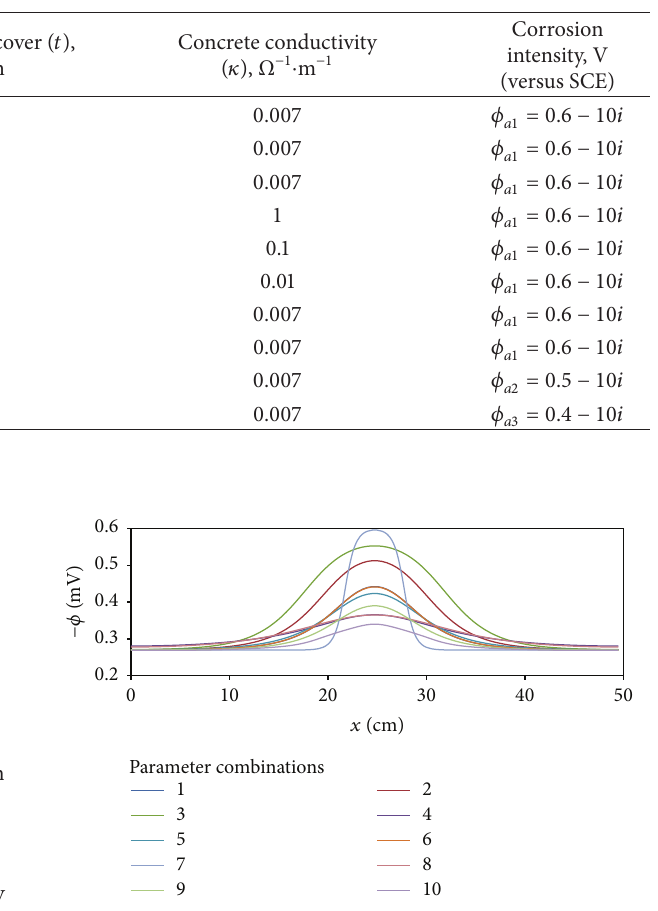
Table 1: 10 combinations of parameters for evaluating the nature of the RC corrosion detection problem.